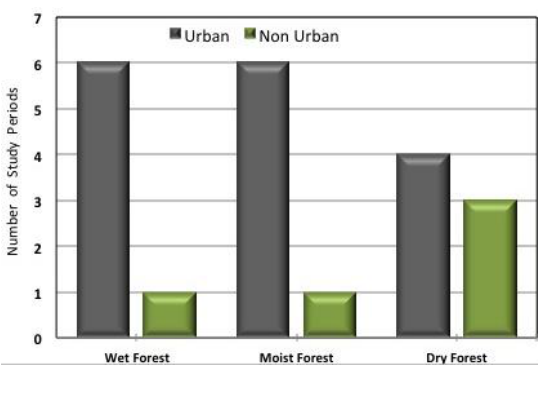
Figure 27. Number of study periods recording higher urban vs. non-urban precipitation